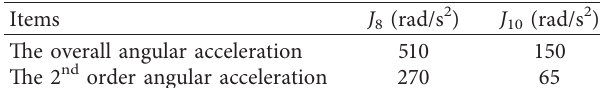
Table 7: Angular acceleration amplitudes under the idling con- dition of the powertrain matching the DMF with the bifilar CPVA.